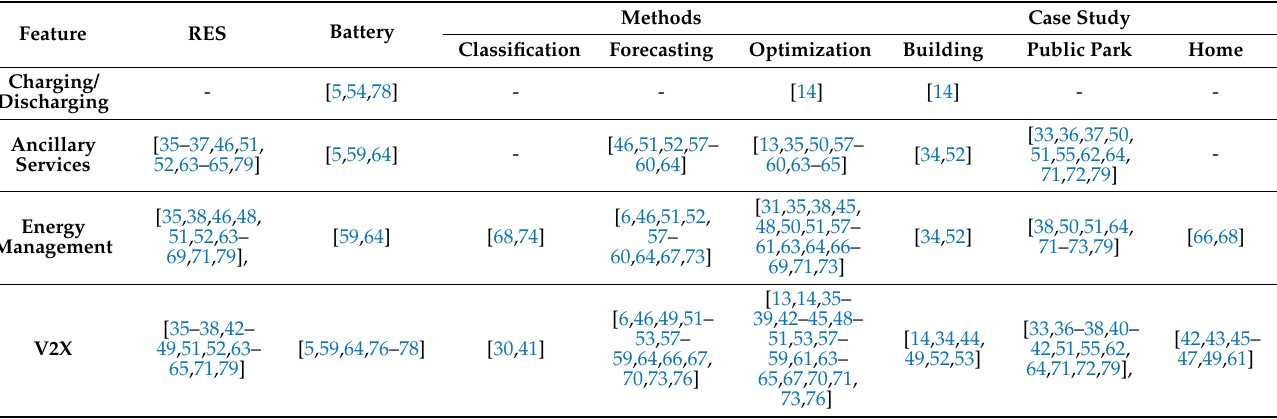
Table 6. Existing works addressing different